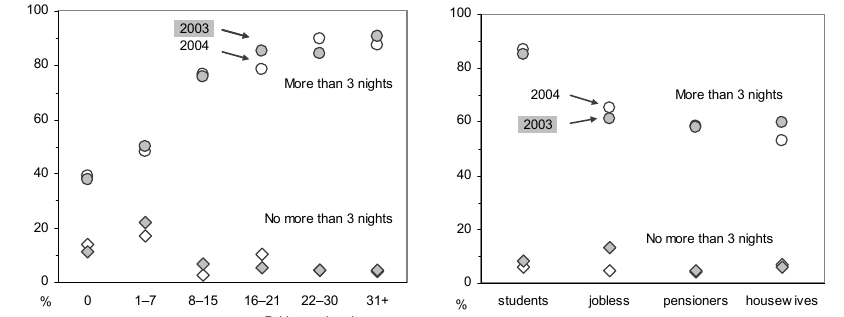
Figure 5 – Workers who took at least one long or short holiday.